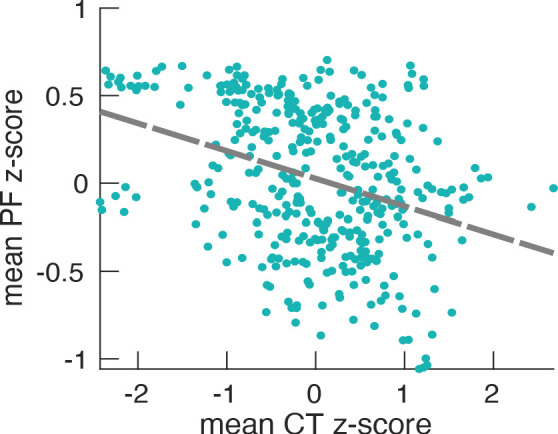
Relationship between PF (187 participants, 384 ROIs) and CT.The scatter plot represents the dependency between the trimmed mean PF and the trimmed mean-CT and their correlation (r = −0.14, p<0.001). This low correlation (although very significant) actually reflects the fact that correlation analysis is not optimal in this case. It does not take into consideration the variability between participants (e.g. the fact that some participants have an overall higher occipital alpha frequency compared to others). This is also one of the reasons for the large scattering of values in the plot. Therefore, LMEM is the preferred statistical tool because it models specifically the inter-individual differences and, as a result, leads to more robust and highly significant results.